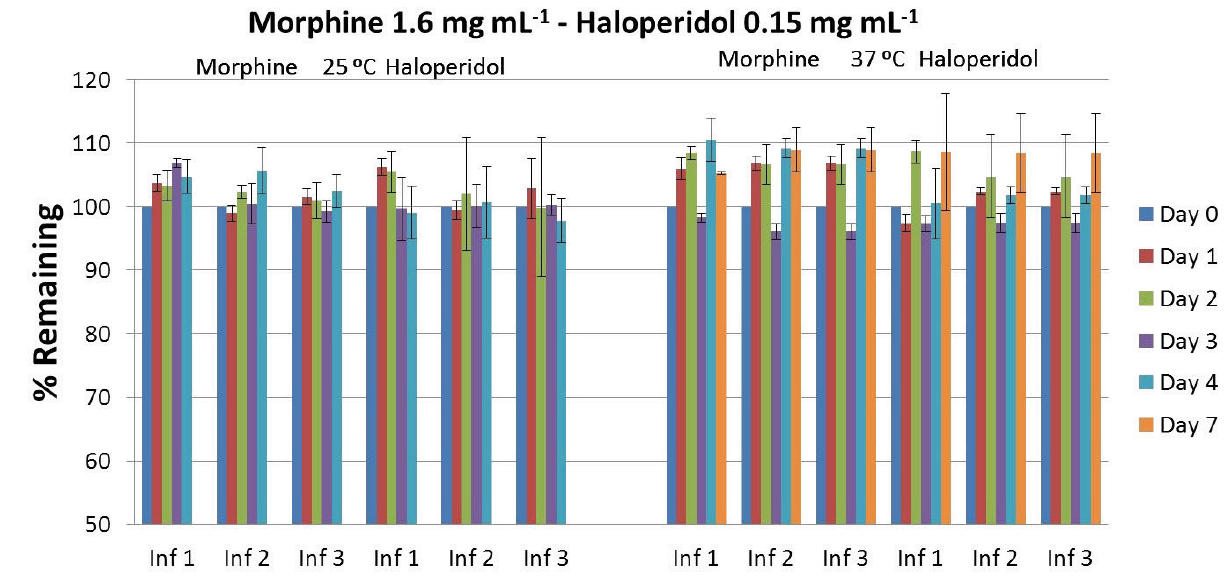
FIGURE 3 - Percentages of mixtures remaining at 25 ºC and 37